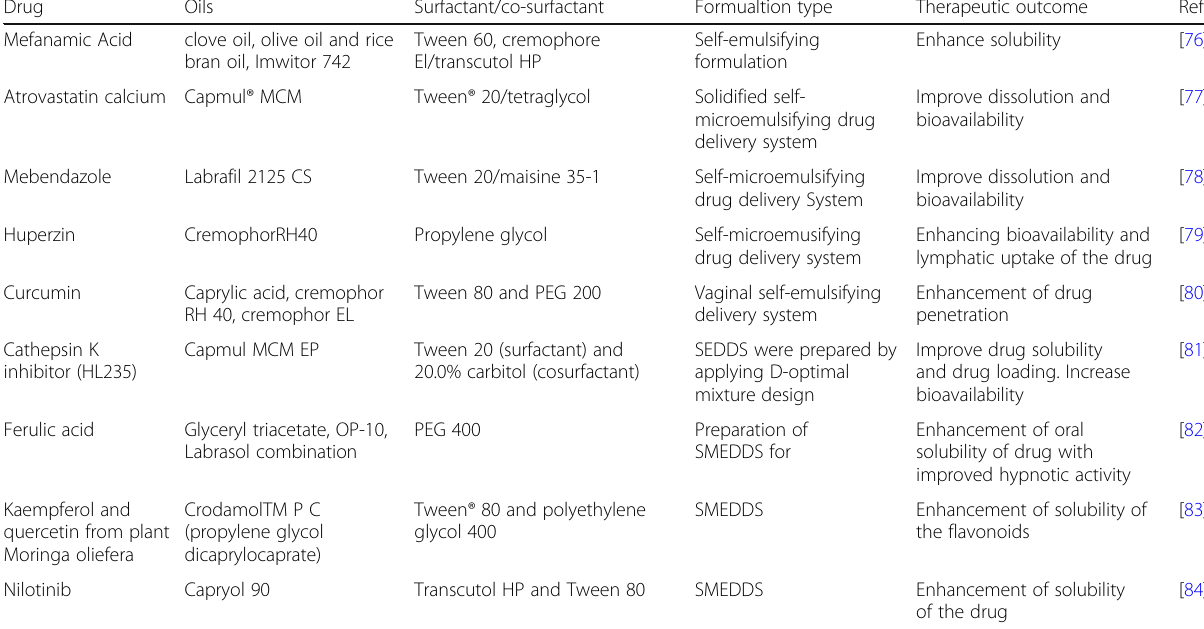
Table 3 List of drugs formulated as solid/liquid self-micro emulsified drug delivery systems (SMEDDS) (Continued) Drug Oils